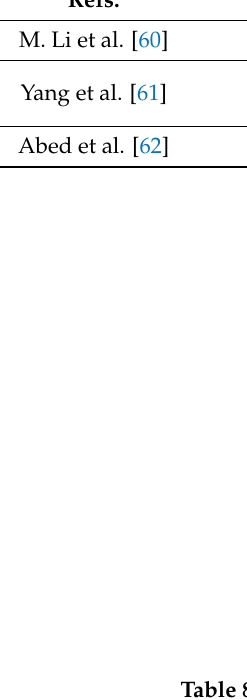
Table 8. Other DL-based methods used for fault bearing diagnosis research comparison. Refs.